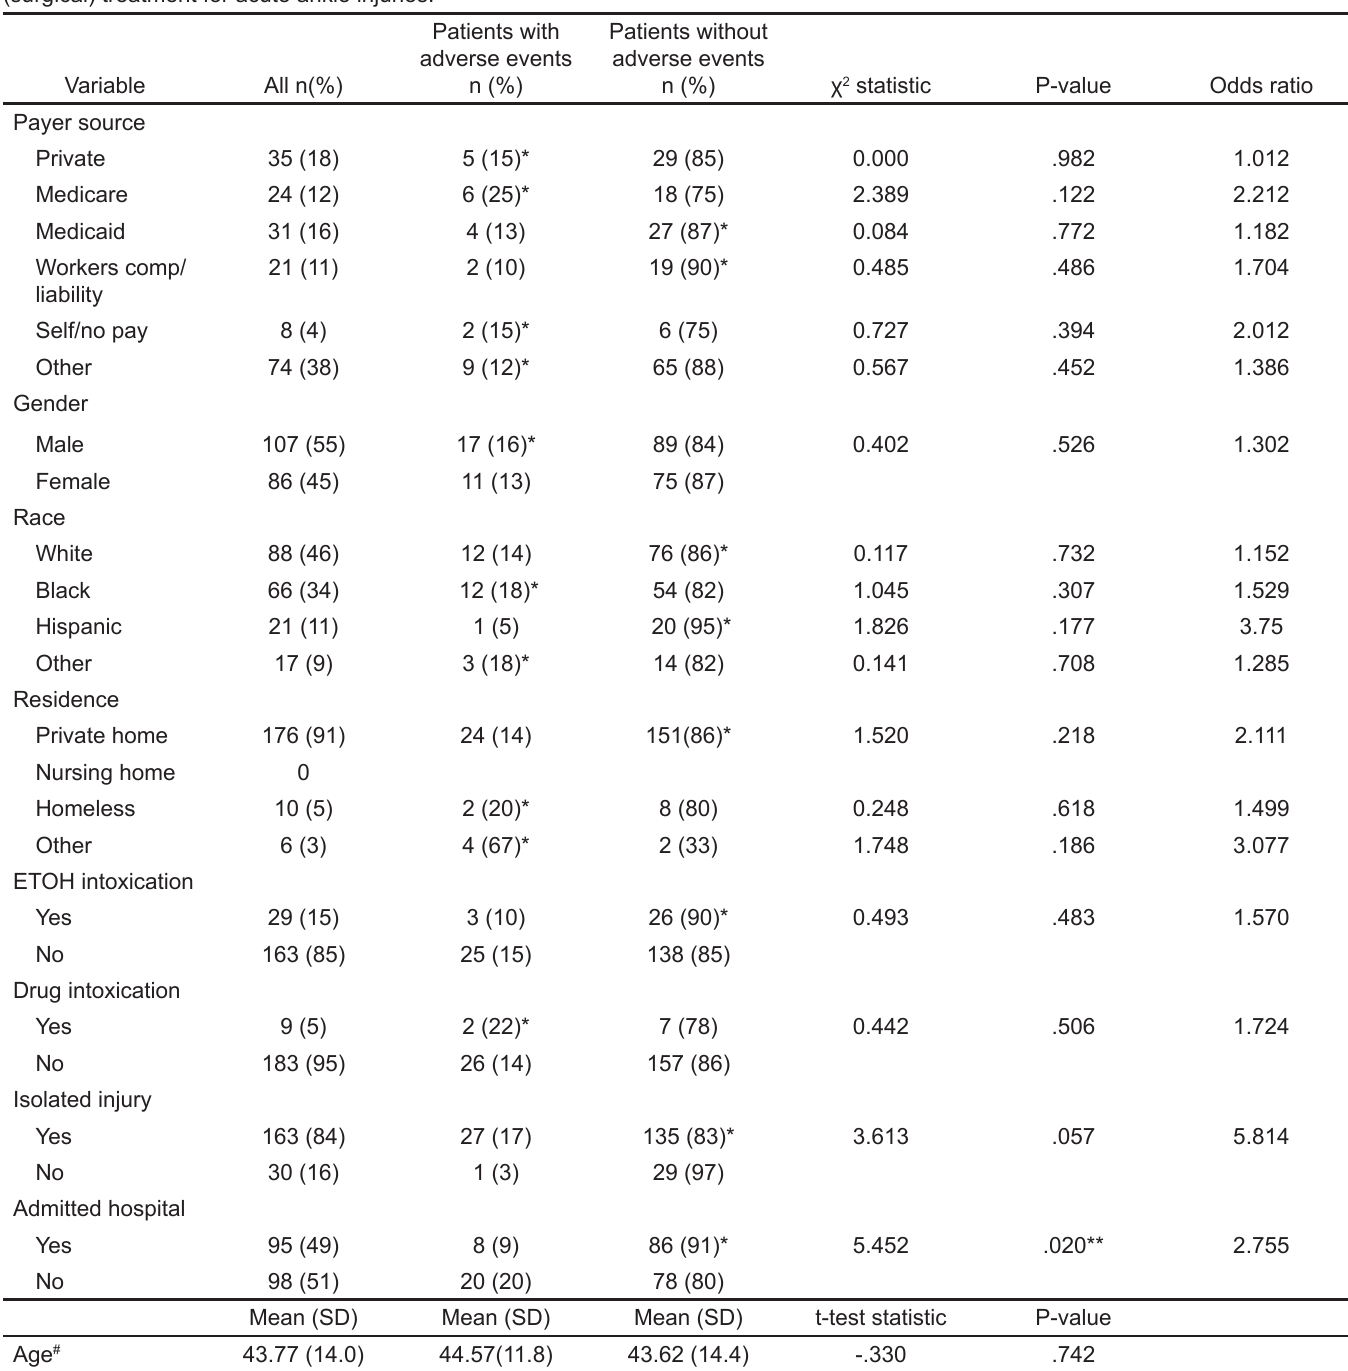
Table 2. Demographics and chi-square calculated p-values for subjects with and without adverse events prior to obtaining terminal (surgical) treatment for acute ankle